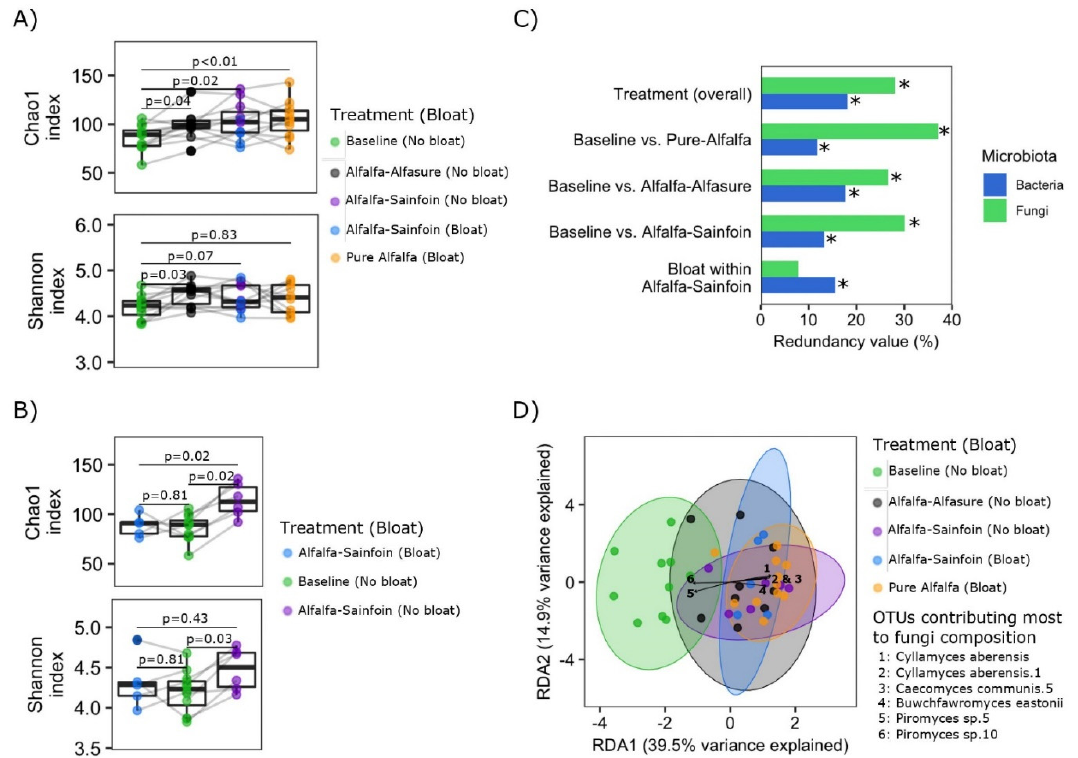
Figure 1. Comparisons of richness, diversity, and composition of rumen fungi communities in steers fed alfalfa hay or grazing alfalfa or alfalfa-sainfoin pastures. ( A ) Comparison of richness (Chao1 index) and diversity (Shannon index) among treatment groups and ( B ) comparisons of richness (Chao1 index) and diversity (Shannon index) among baseline hay diet and bloated and non-bloated steers on the alfalfa-sainfoin diet. Boxes show the interquartile range with the line at the median and whiskers showing minimum and maximum values. A line between two individual dots indicates the same steer in di ff erent groups. Comparisons were tested using Wilcoxon signed-rank test. ( C ) Summary statistics of redundancy analyses assessing the association of the overall composition of fungal and bacterial communities with treatments in general (top), individual pair-wise comparisons between baseline hay diet and each of the alfalfa pasture treatments (three middle), and bloated vs. non-bloated steers within the alfalfa-sainfoin treatment (bottom). Redundancy values indicate the percentage of observed variation in fungal composition explained by each factor (Treatment overall, n = 44; Pairwise comparisons: Baseline vs. Prue-Alfalfa, n = 22; Baseline vs. Alfalfa-Alfasure ® , n = 20; Baseline vs. Alfalfa-Sainfoin, n = 22; Bloat vs. non-bloat in Alfalfa-Sainfoin, n = 11). * = p < 0.05. ( D ) Redundancy analysis bi-plot depicting di ff erences in fungal composition between treatment groups / bloat status. Arrows indicate 7 amplicon sequence variants (ASVs) that accounted for most of the di ff erences in fungal composition (e.g., Neocallimastigaceae sp7 and sp3 (arrows ID 1 and 2) tended to be enriched in the rumen contents of steers fed the baseline